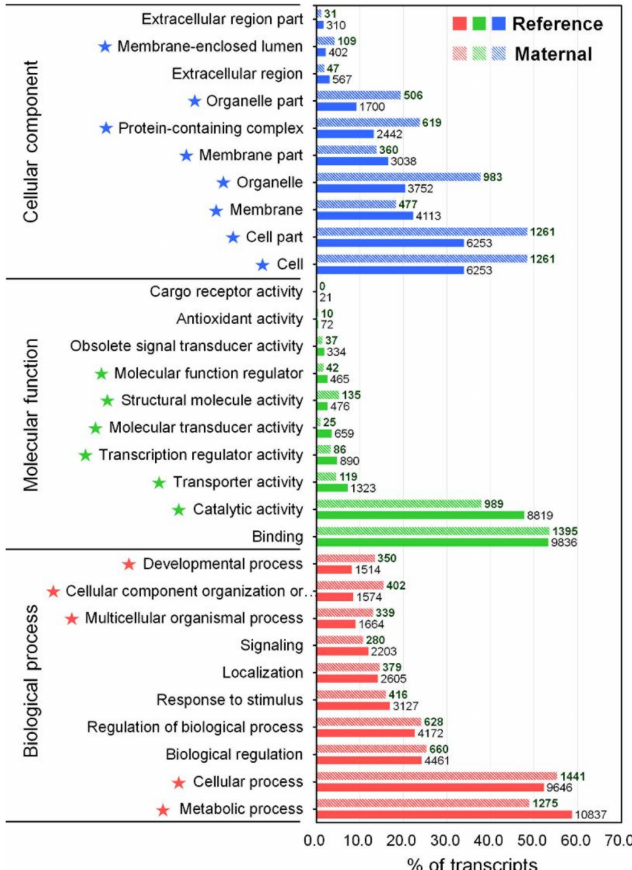
Figure 2. GO classification for the reference transcriptome and enrichment analysis of maternal gene transcripts using the Pearson Chi-Square test. Horizontal axis displays the percentage of significant transcripts in each column of which the number at the end indicates the number of transcripts. Vertical axis displays the detailed GO term corresponding to each functional type. Star marks in front of terms indicate significantly enriched GO terms ( p <